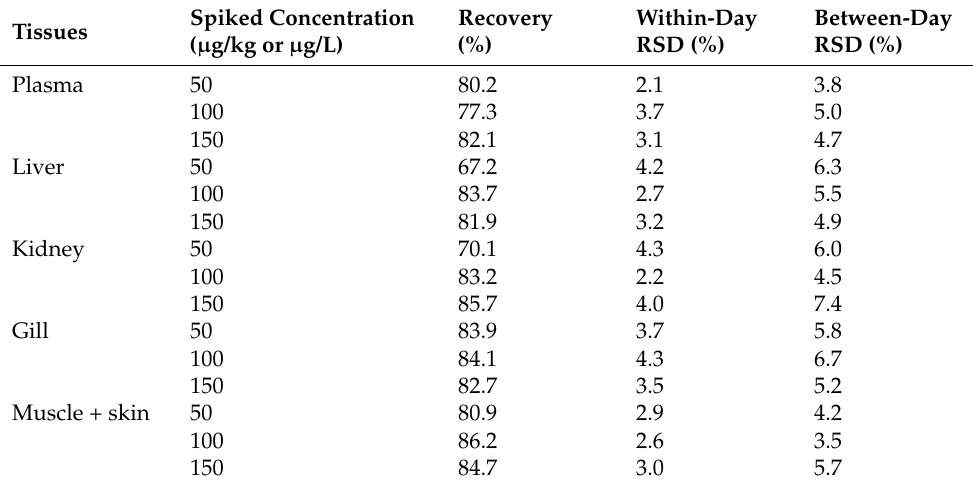
Recovery Within-Day Between-Day (%) RSD (%) RSD (%)